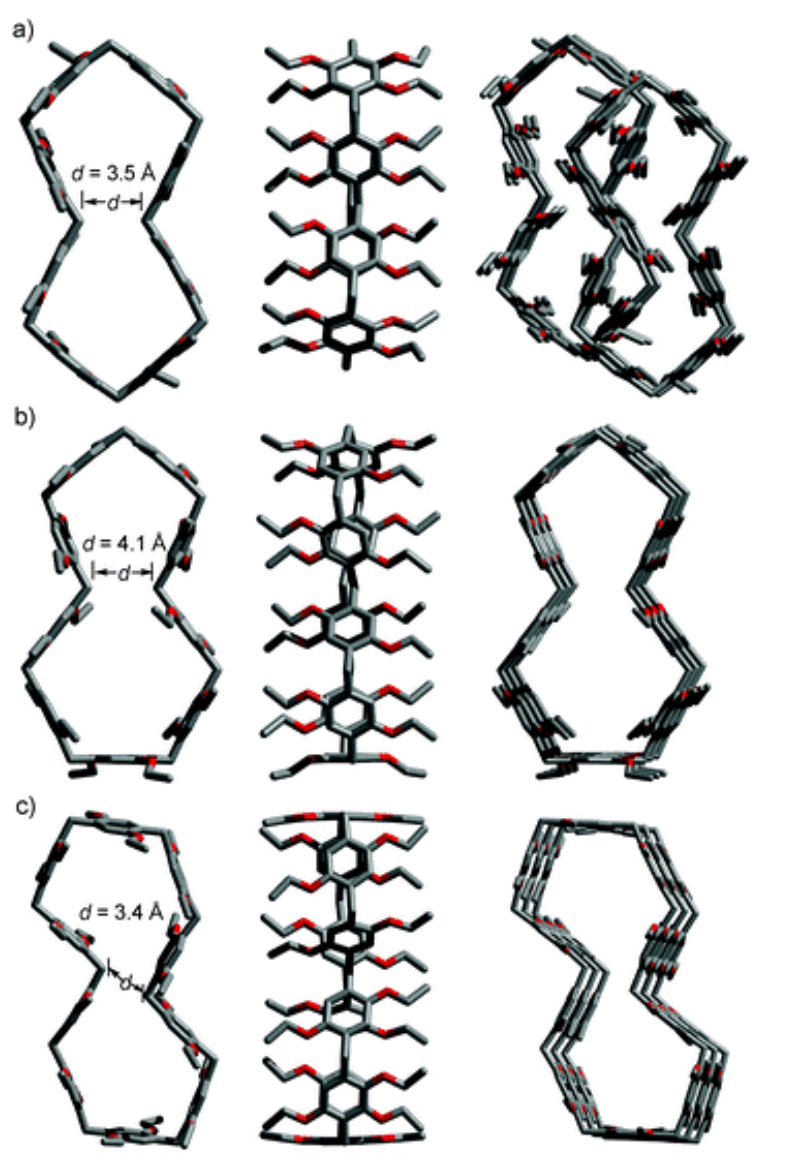
Figure 6. Upper ( left ) and side view ( middle ), as well as packing model ( right ) of X-ray single-crystal structures of ( a ) pillar[8]arene, ( b ) pillar[9]arene and ( c ) pillar[10]arene. The hydrogen atoms were omitted for clarity [94]. Copyright © 2012 by The Royal Society.